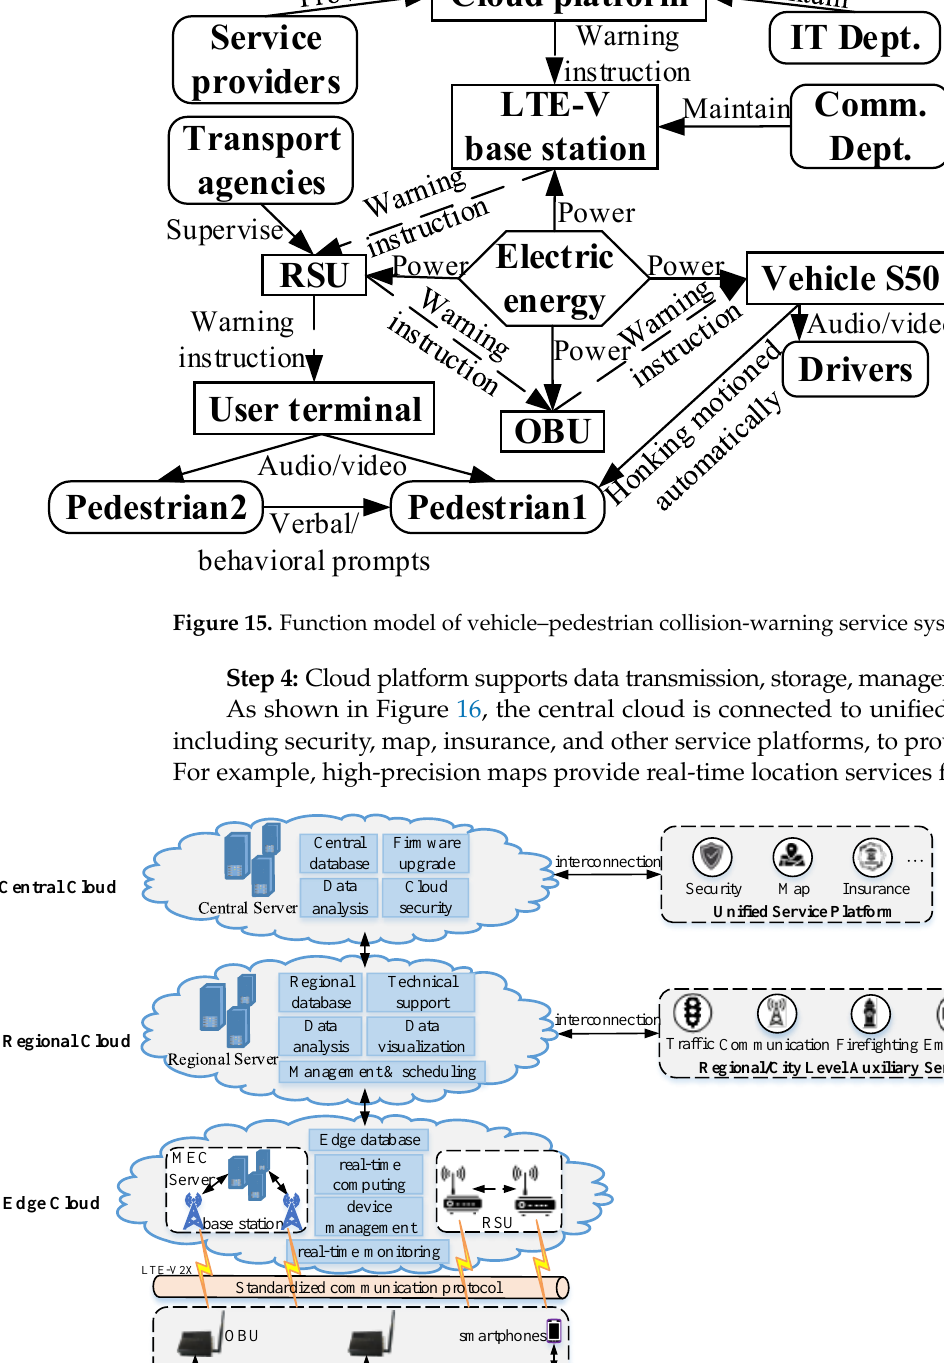
Figure 15. Function model of vehicle – pedestrian collision-warning service system.